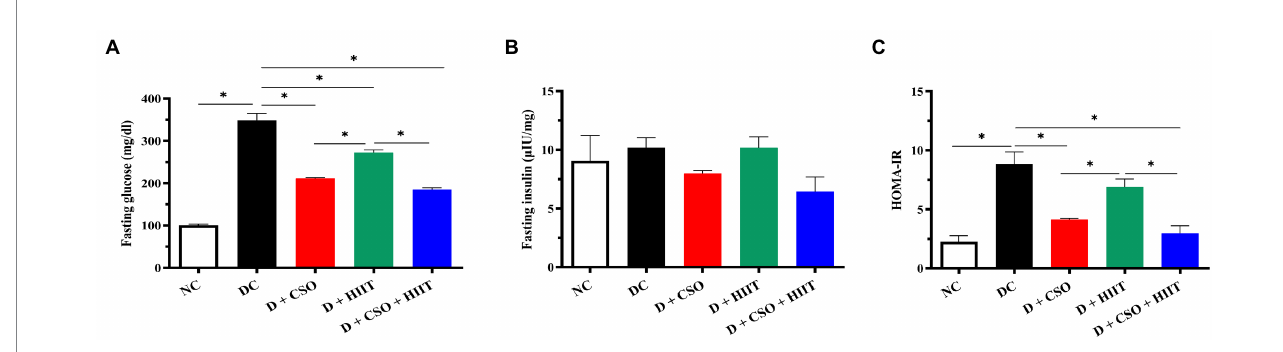
FIGURE 5 The effect of D, D + CSO, D + HIIT, and D + CSO + HIIT on glycemia markers including (A) glucose, (B) insulin, and (C) HOMA-IR. One-way ANOVA followed by Tukey post-test was used. Data are represented as means ± SEM and significant differences between groups are indicated by * p < 0.05. NC, Normal control; DC, Diabetic control; D + CSO, Diabetic + camelina sativa oil; D + HIIT, Diabetic + HIIT; D + c + HIIT, Diabetic + camelina sativa oil +